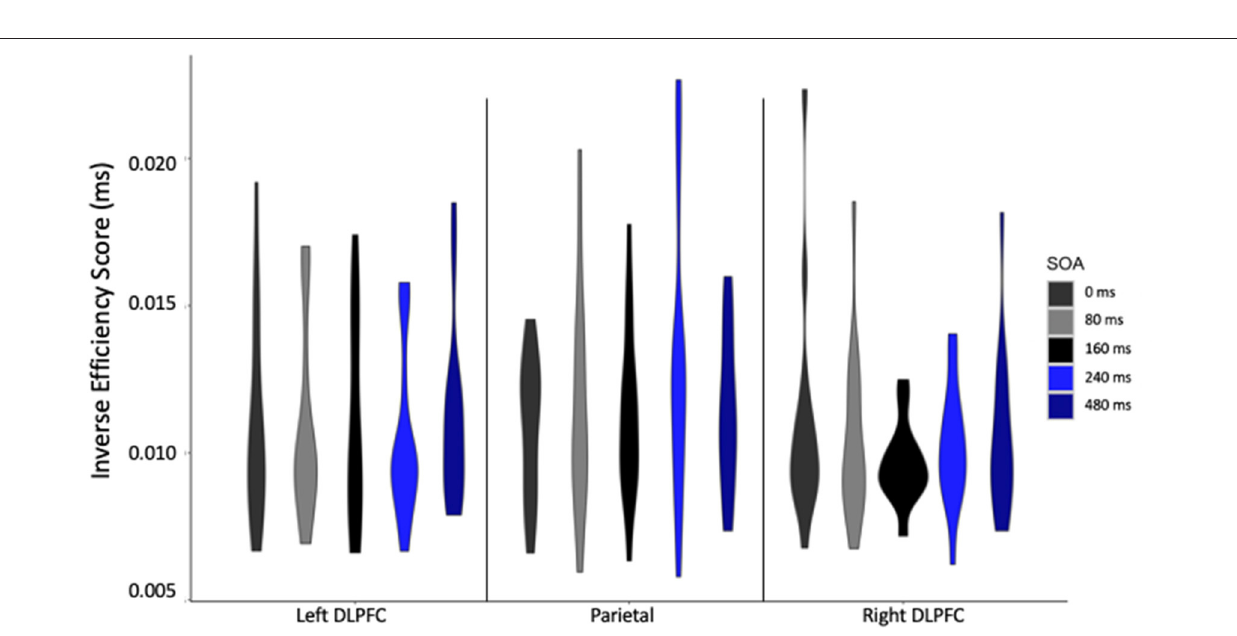
afford; Binkofski and Buccino, 2018). Such mapping is